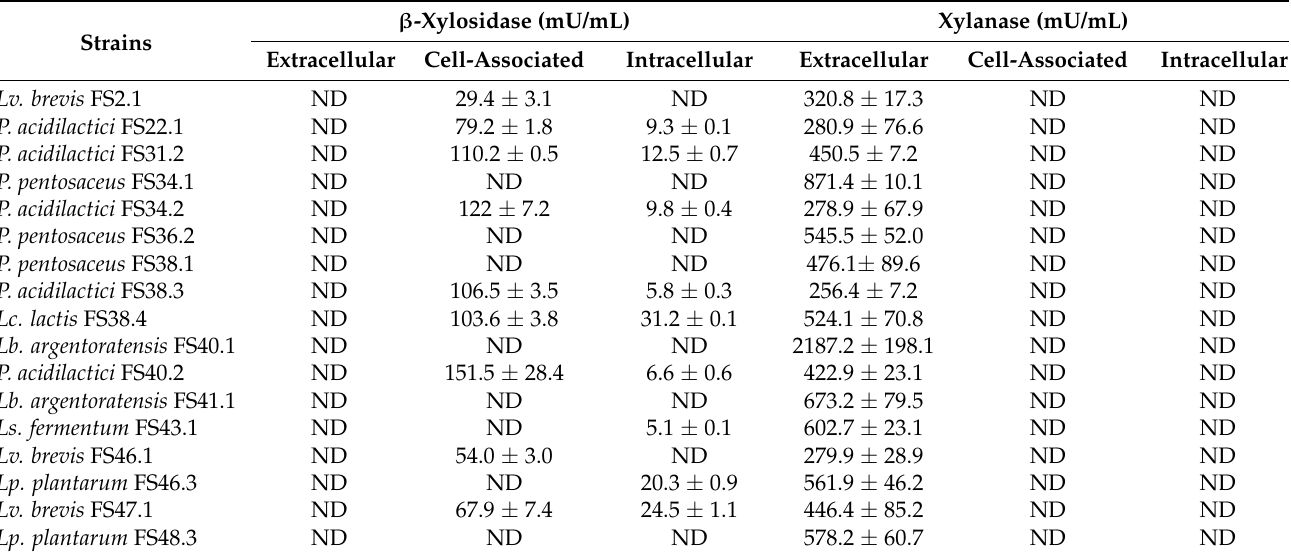
Table 6. β -xylosidase and xylanase activities of XOSs-fermenting LAB after being grown in MRSB- XOSs at 37 ◦ C for 24 h.